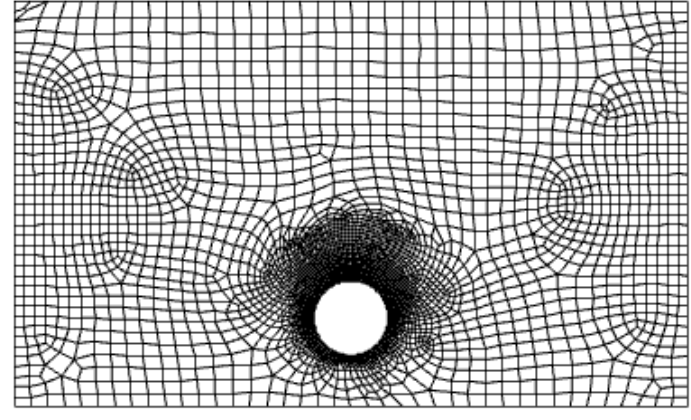
Figure 1. Computational domain and mesh